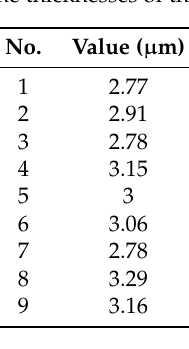
Table 6. The thicknesses of the coatings.